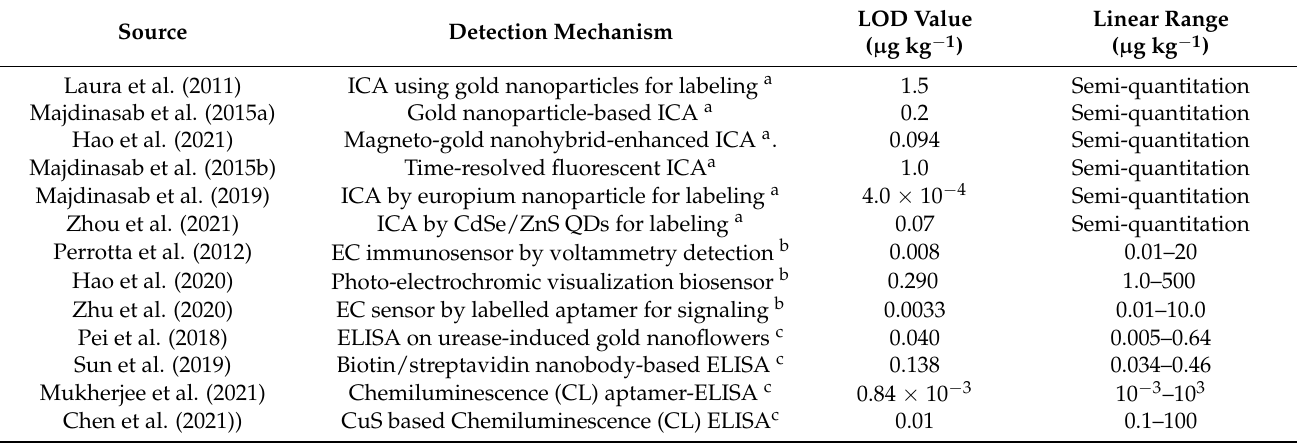
Table 2. Representative heterogeneous bioassays for rapid screening of Ochratoxin A.